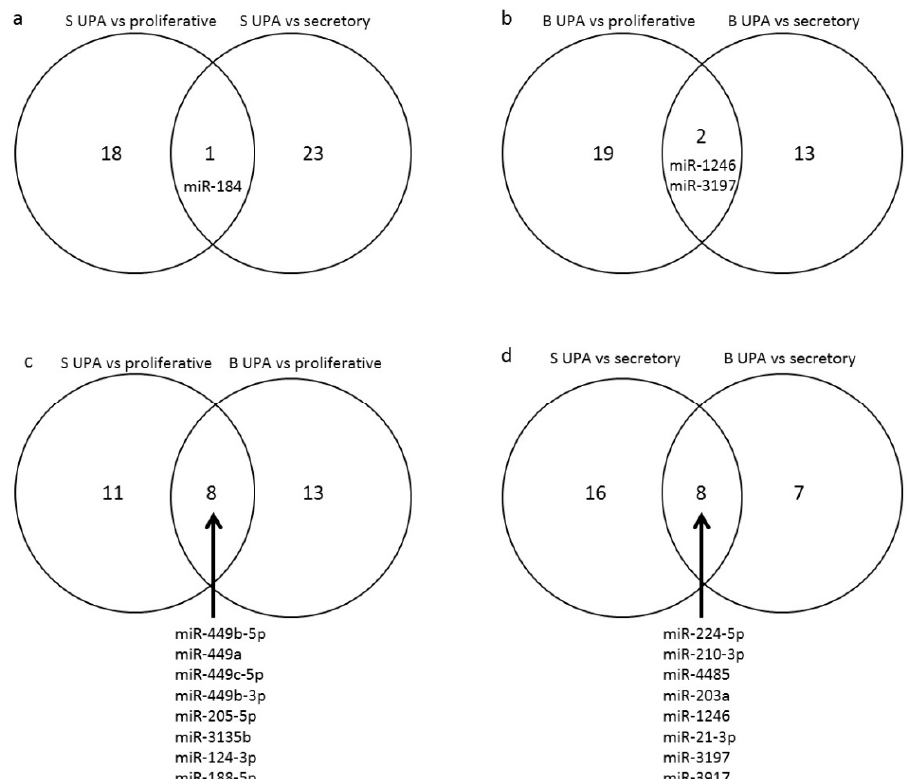
Figure 3. Venn diagrams representing common miRNA identified in the analyses. In the superficial layer (S), 18 miRNA were differentially expressed in UPA group as compared to the proliferative phase group and 23 as compared to secretory phase group. miR-184 was differentially expressed in the UPA group as compared to both the proliferative and secretory phase groups ( a ). In the basal layer (B), 19 miRNA were differentially expressed in the UPA group as compared to the proliferative phase group and 13 miRNA as compared to the secretory phase group. miR-1246 and miR-3197 were differentially expressed in the UPA group compared to both the proliferative and secretory phase groups ( b ). When comparing UPA to the proliferative phase group, 11 miRNA were differentially expressed in the superficial layer, 13 in the basal layer and 8 miRNA (miR-449b-5p, miR-449a, miR-449c-5p, miR-449b-3p, miR-205-5p, miR-3135b, miR-124-3p, miR-188-5p) were differentially expressed in both endometrial layers ( c ). When comparing UPA to the secretory phase group, 16 miRNA were differentially expressed in the superficial layer, 7 in the basal layer and 8 (miR-224-5p, miR-210-3p, miR-4485, miR-203a, miR-1246, miR-21-3p, miR-3197, miR-3917) were differentially expressed in both endometrial layers ( d ).